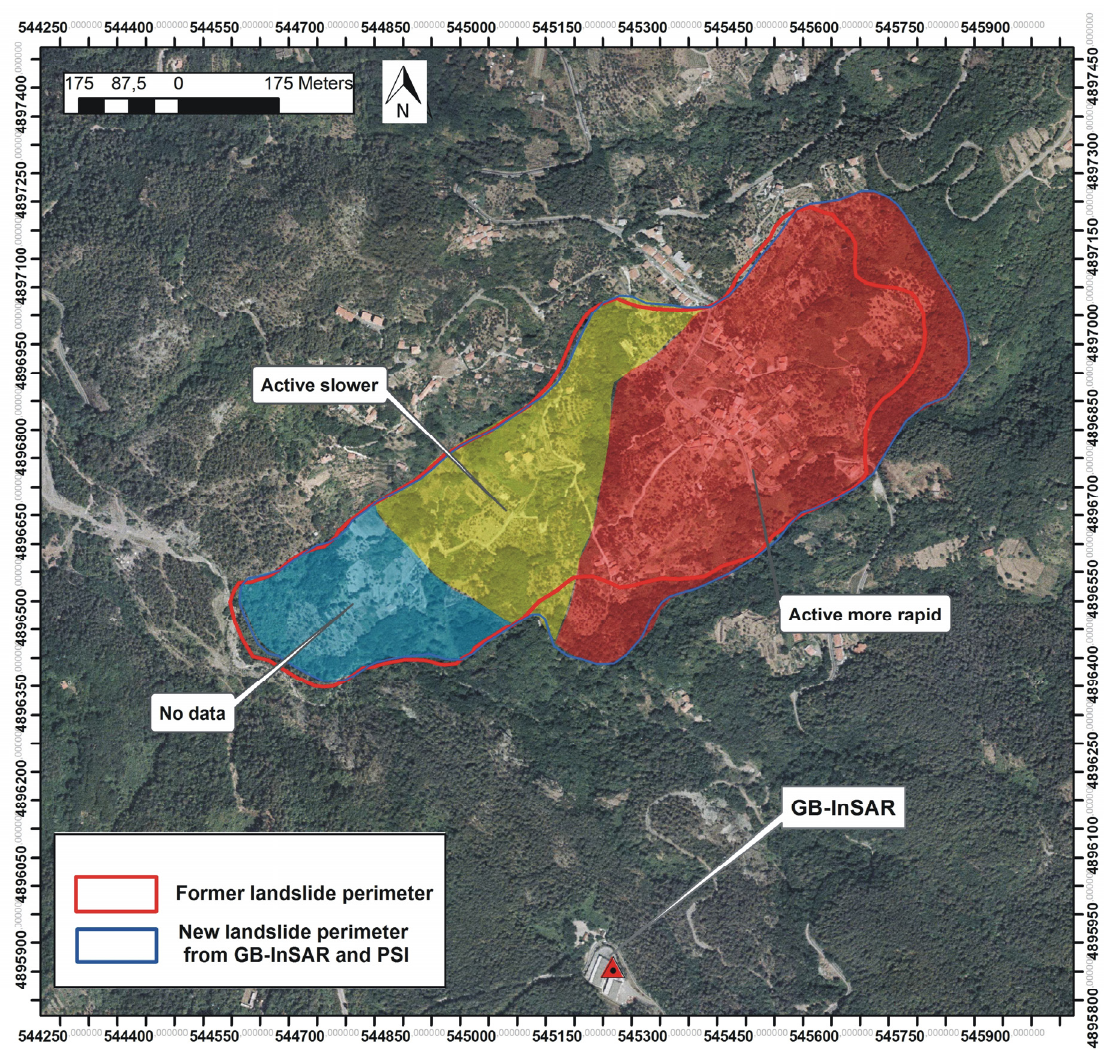
Figure 10. Updated landslide perimeter and landslide intensity